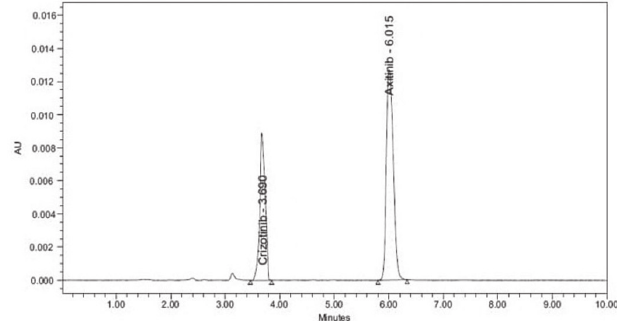
FIGURE 7 - Chromatogram of ULOQ.